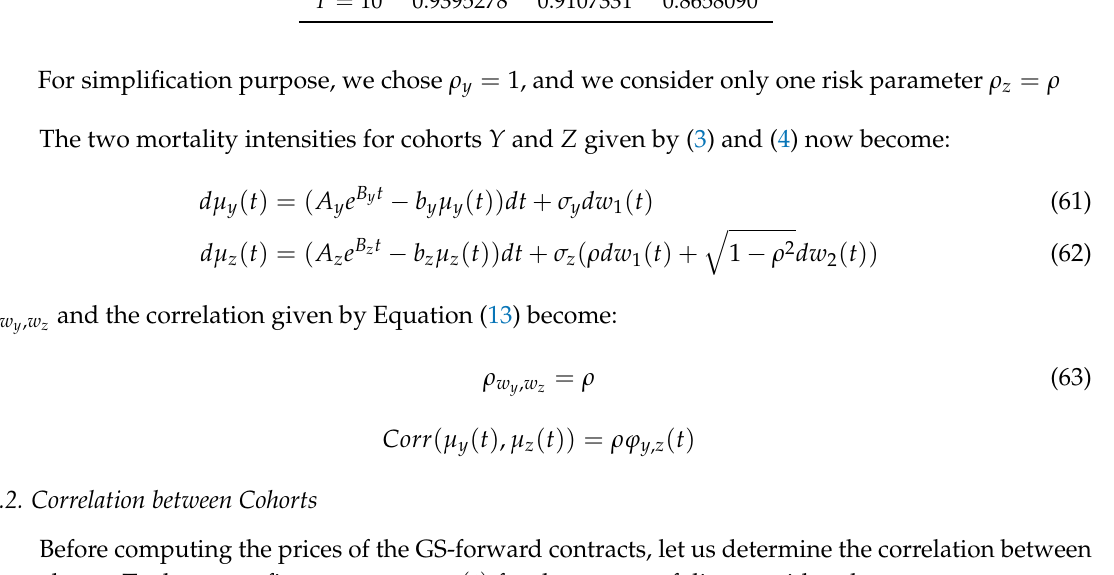
Table 2. The fixed survival rates